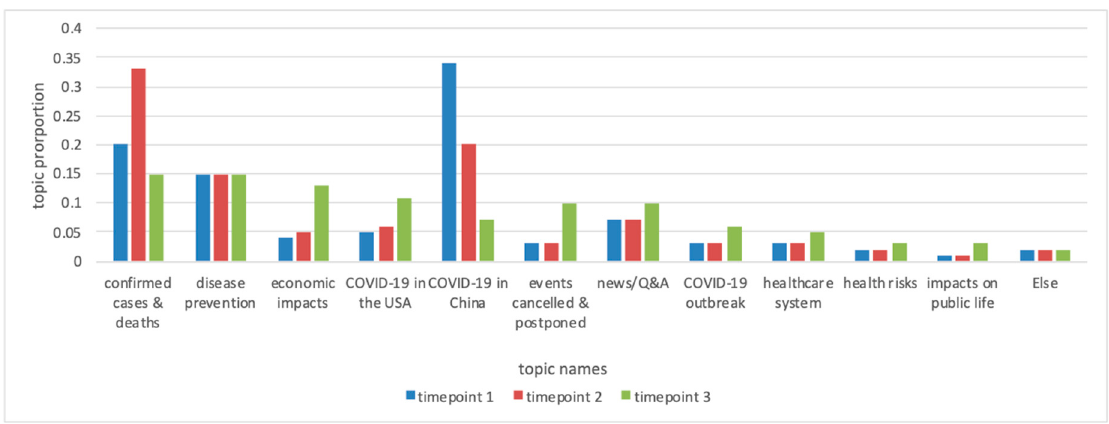
Figure 1. Topic proportions at the three time points.